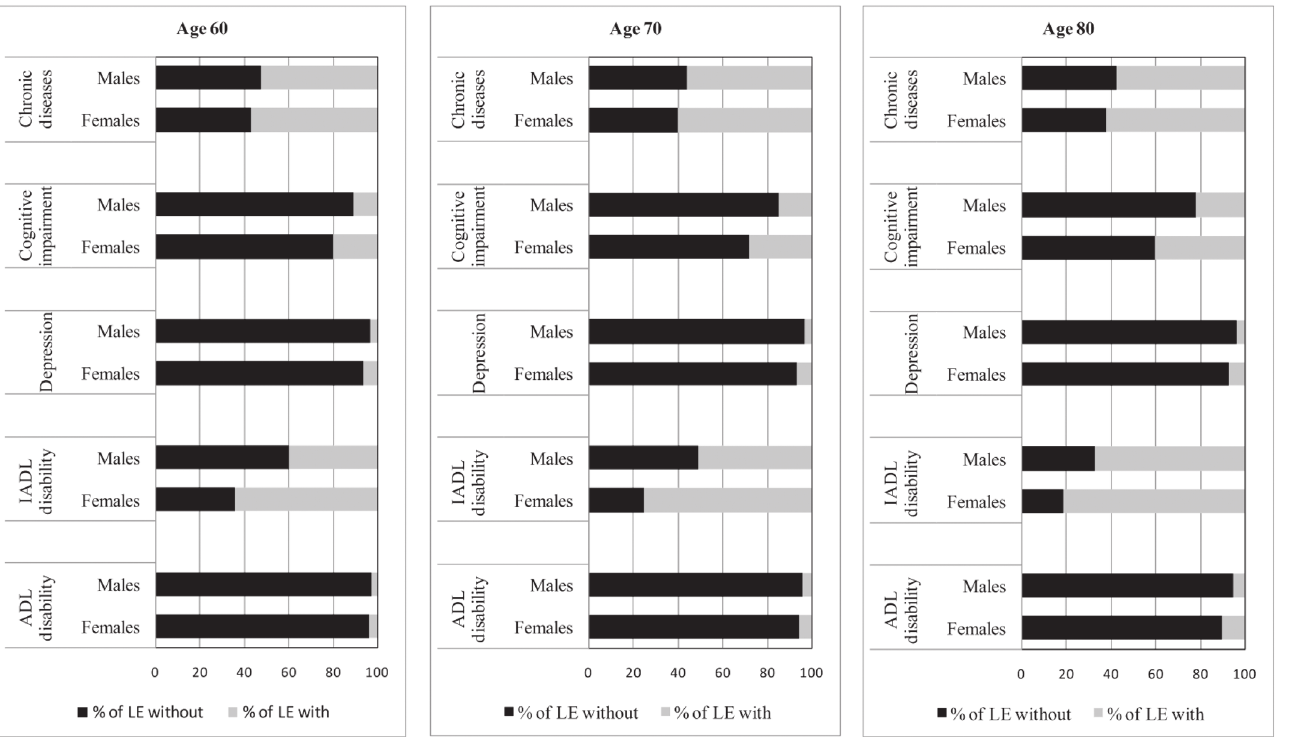
Fig 2. Proportion of total life expectancy (LE) spent without and with morbidity and disability by age and genders in Thailand, 2009.